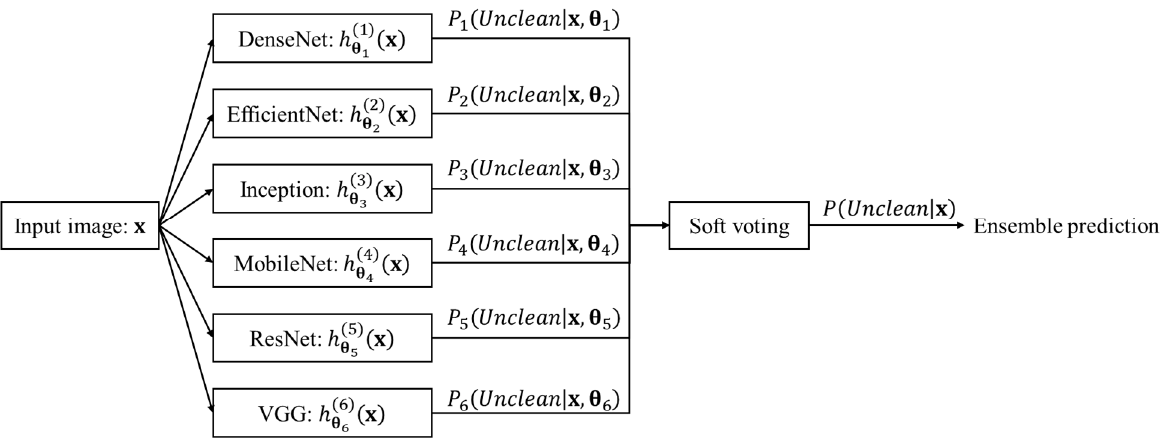
Figure 1. Soft voting ensemble classifier consisting of six models.